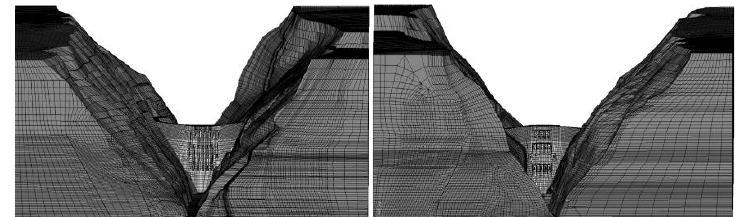
Figure 12. Three-dimensional finite element model of Jingping-I arch dam (upstream and downstream viewpoints).